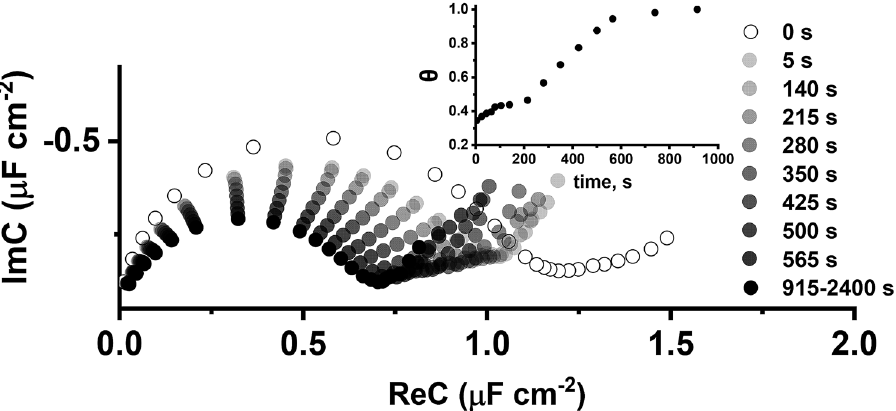
Figure 4. Cole–Cole plots of FFT impedance spectra of the DOPC:Chol (molar % ratio 6:4) vesicle fusion process on silanized aluminum surface. The applied potential: − 0.7 V versus Ag/AgCl/NaCl (sat.) . Inset—surface coverage, θ, of the lipid layer over